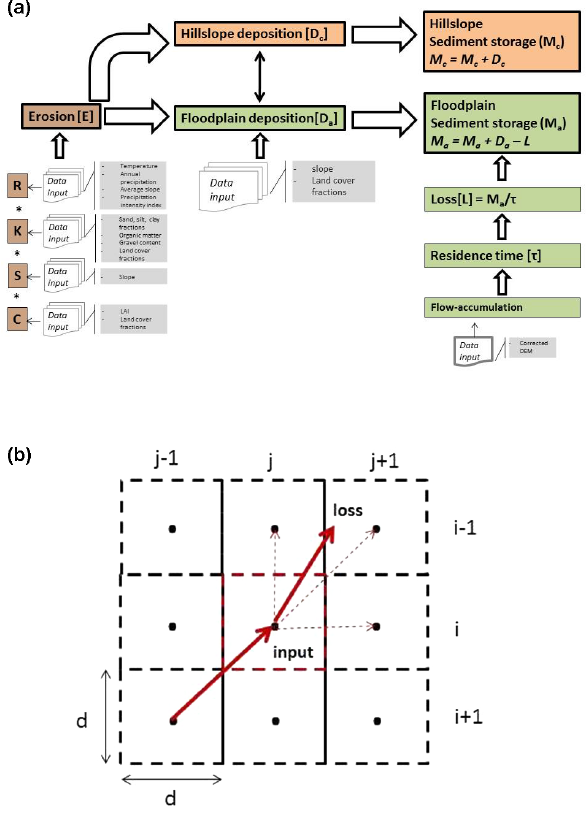
Figure 1. Model scheme (a) with multiple flow routing (b)